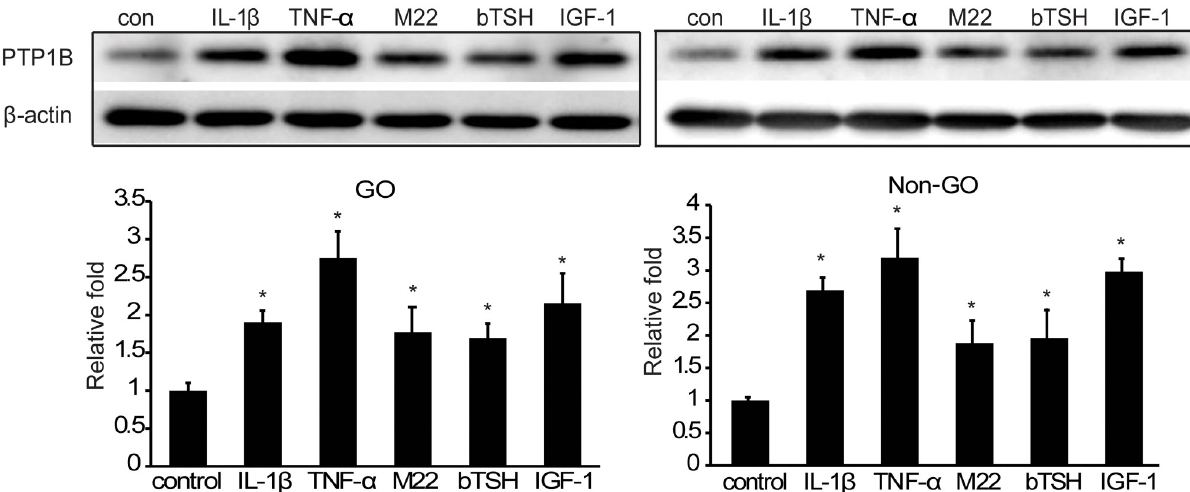
Fig 1. PTP1B protein expression stimulated by proinflammatory cytokines, TSH Receptor (TSHR), and IGF-1R ligands. Orbital fibroblasts cultured from GO and non-GO tissues were treated with IL-1 β (10 ng/mL), TNF- α (10 ng/mL), M22 (10 ng/mL), bTSH (2.5 mU/mL), or IGF-1 (100 ng/mL) for 48 hours. Cell lysates were subjected to western blot. IL-1 β , TNF- α , M22, bTSH, and IGF-1 significantly increased the expression of PTP1B protein in both GO and non-GO fibroblasts. Experiments were performed in three GO and non-GO cells from different individuals. Data in the columns indicate the mean density ratio ± SD by densitometry normalised to the level of β -actin in the same sample. Representative gel images are shown. Differences between treated and untreated cells are indicated ( � p < 0.05). See S3 Fig for uncropped blots.